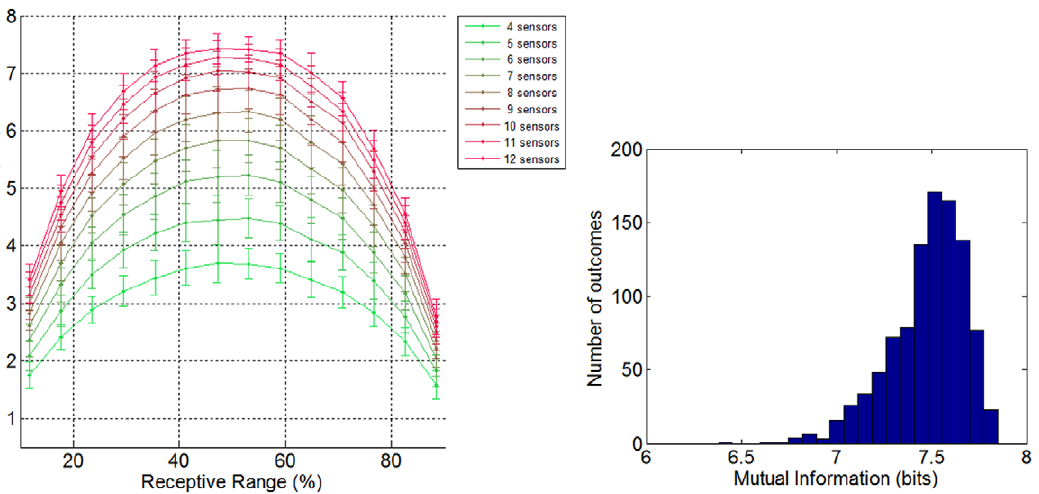
Figure 4. Mutual Information for odor coding. Top: Mean performance of different sized arrays of receptors and different receptive range. Mean and standard deviation (after 1,000 repetitions) of the evaluated coding capacity for homogenous groups of 4, 5, 6, 7, 8, 9, 10, 11, and 12 receptors for different RR of the receptors . The MI was calculated with sets of 256 stimuli, which limit the maximum array performance to 8 bits. The coding capacity increases with the number of receptors and there is an optimum coding capacity when the RR is about 50%. More selective (less RR) or less selective (more RR) gives a degraded performance. Bottom. Performance distribution of a 12-receptor array. Distribution of calculated MI for a 12-receptor array and 53% RR, after 1,000 trials. The histogram corresponds to step 5 of the routine (see figure 1) and is used to calculate the mean performance and standard deviation of the ensemble (top). doi:10.1371/journal.pone.0037809.g004 RR= 59.0%) that performs at least 0.15 bits better than the best same RR of about 50%; see figure 4, left).